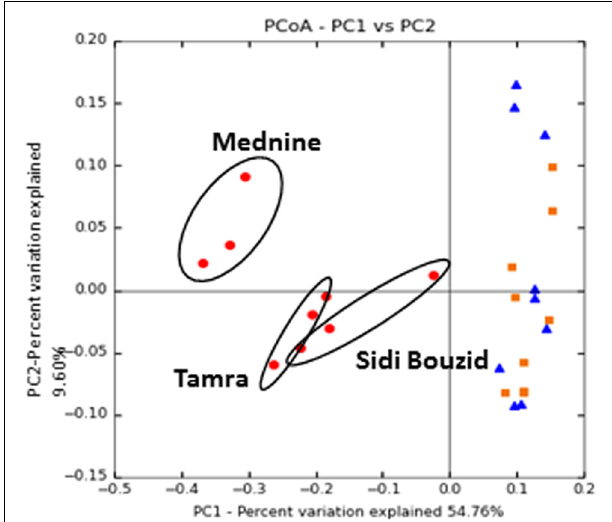
FIGURE 5 | Principal coordinates ordination of CSS normalized UniFrac distance matrices: Ordinations where normalized using Cumulative Sum Scaling. Ordinations was made using the weighted UniFrac distance. Symbols represent: nodules ( • ), rhizosphere ( (cid:4) ), and soil ( (cid:78) ). For all ordinations MRPP showed a statistically significant grouping of the nodule samples, as outlined in Supplementary Table 4